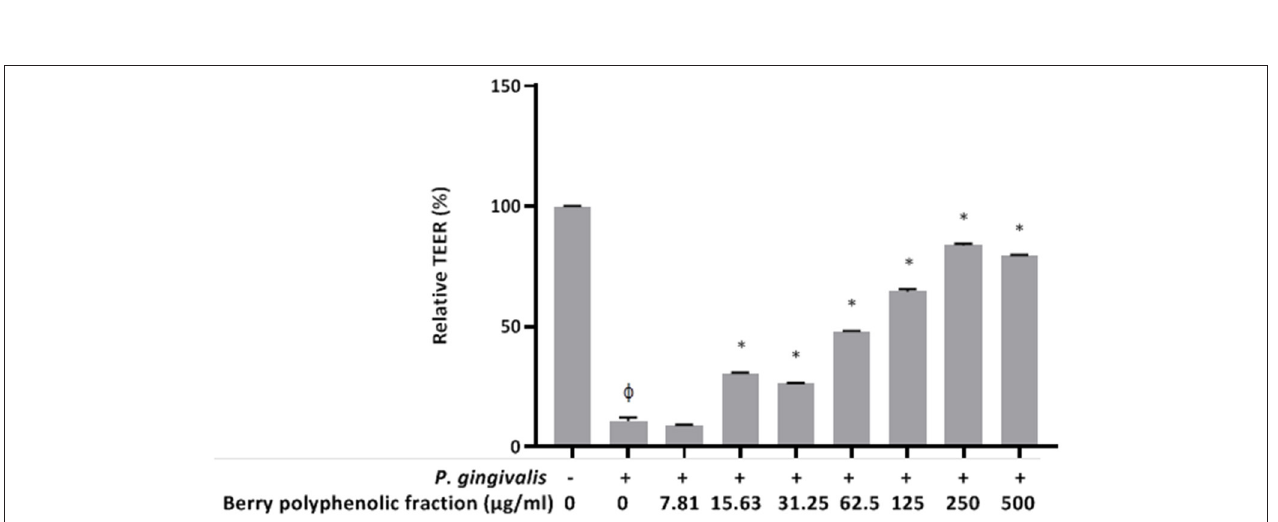
FIGURE 8 | Effect of the berry polyphenolic fraction on P. gingivalis -mediated loss of oral keratinocyte barrier function. The + symbol indicates the presence of P. gingivalis at MOI of 10 3 . A relative value of 100% was assigned to the TEER recorded in the absence of P. gingivalis and the fraction. Results are expressed as the means ± SD of triplicate assays from three independent experiments. ϕ Significant decrease ( p < 0.001) compared to unstimulated control cells. *Significant increase ( p < 0.01) compared to P. gingivalis -stimulated cells not treated with the fraction.